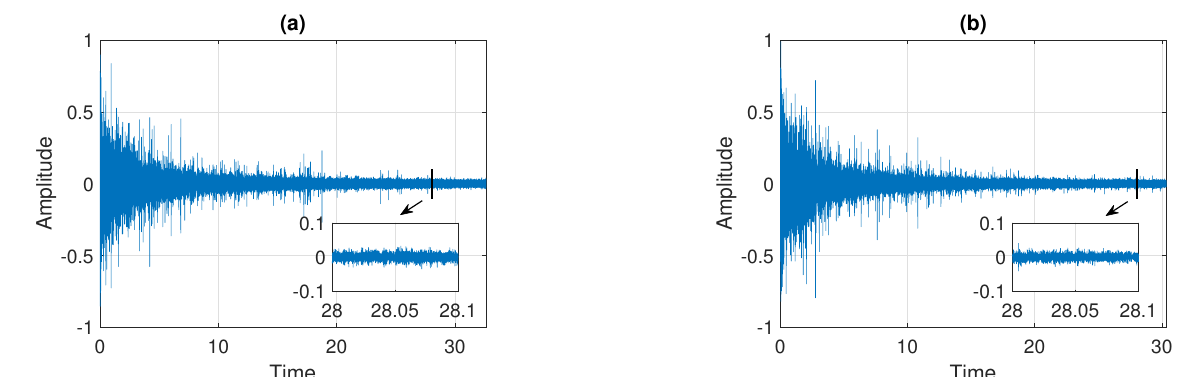
Figure 3. Examples of signals after the pre-processing step. Panel ( a ) corresponds to Signal 1 and panel ( b ) corresponds to Signal 2.